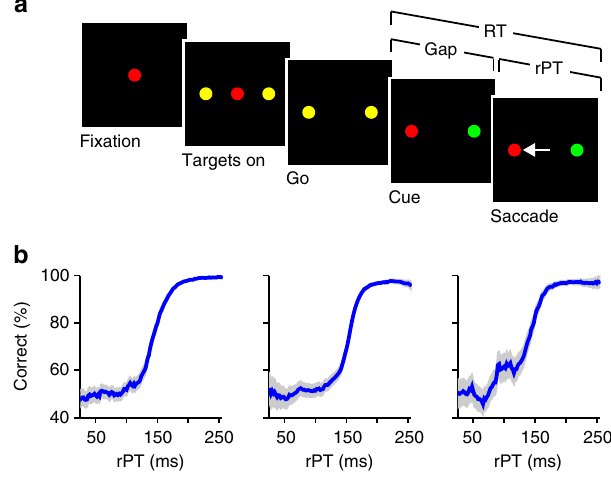
Fig. 1 CS task and psychophysical performance of three monkeys. a The CS task. The color of the initial fi xation spot (Fixation) de fi nes the color of the eventual target. Two identical yellow spots, diametrically opposed, surrounding the central stimulus, represent potential target locations (Targets on/Go). Disappearance of the central fi xation spot represents the command to move, or go signal (Go). Target and distracter are revealed (Cue) only after a variable gap of time (Gap) following the go signal. Choices are indicated via saccadic eye movement (white arrow). Reaction time (RT) is measured between the onset of the go signal and the onset of the saccadic response. Raw processing time (rPT) is measured between cue onset and saccade onset. b Percentage of correct responses as a function of rPT (tachometric curves). Error bars in b represent 95% binomial proportion con fi dence intervals. From left to right, data are from monkeys R ( n = 19,796 trials), T ( n = 11,148 trials), and G ( n = 6042